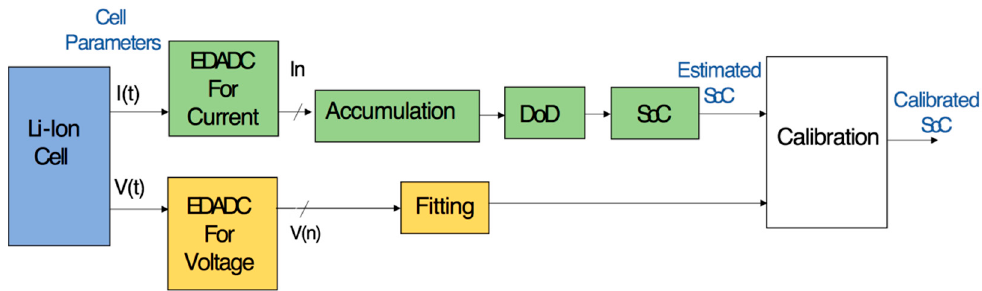
Figure 6. The block diagram of event-driven coulomb counting based method.